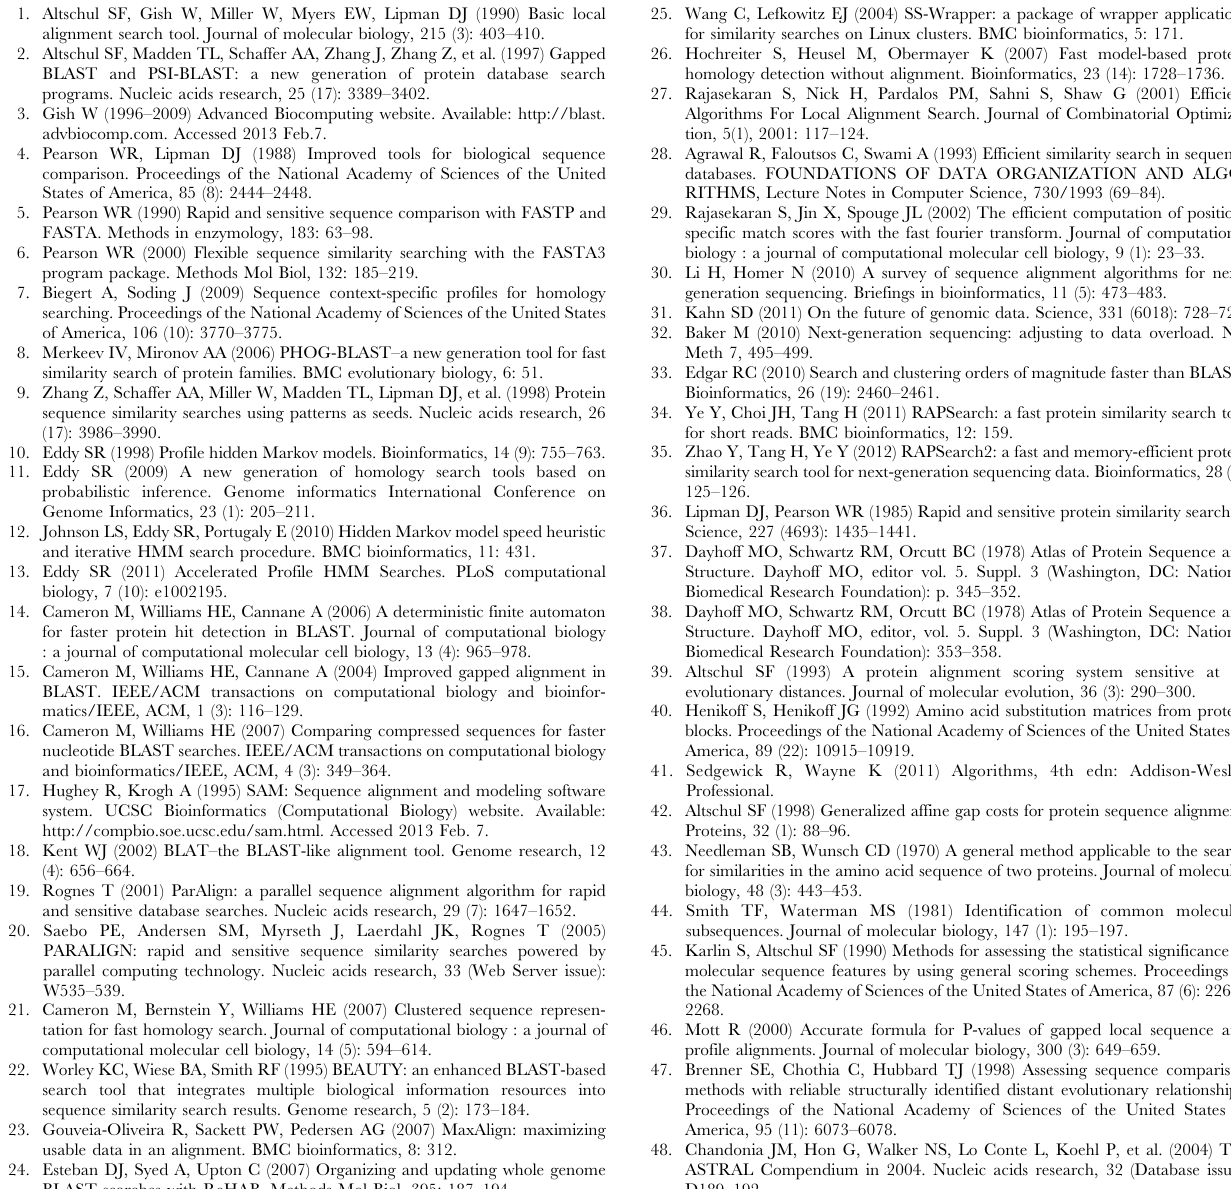
Figure S2 Performance comparison for quick protein similarity search tools calculated using the tools’ own reporting functionality. All measurements were taken